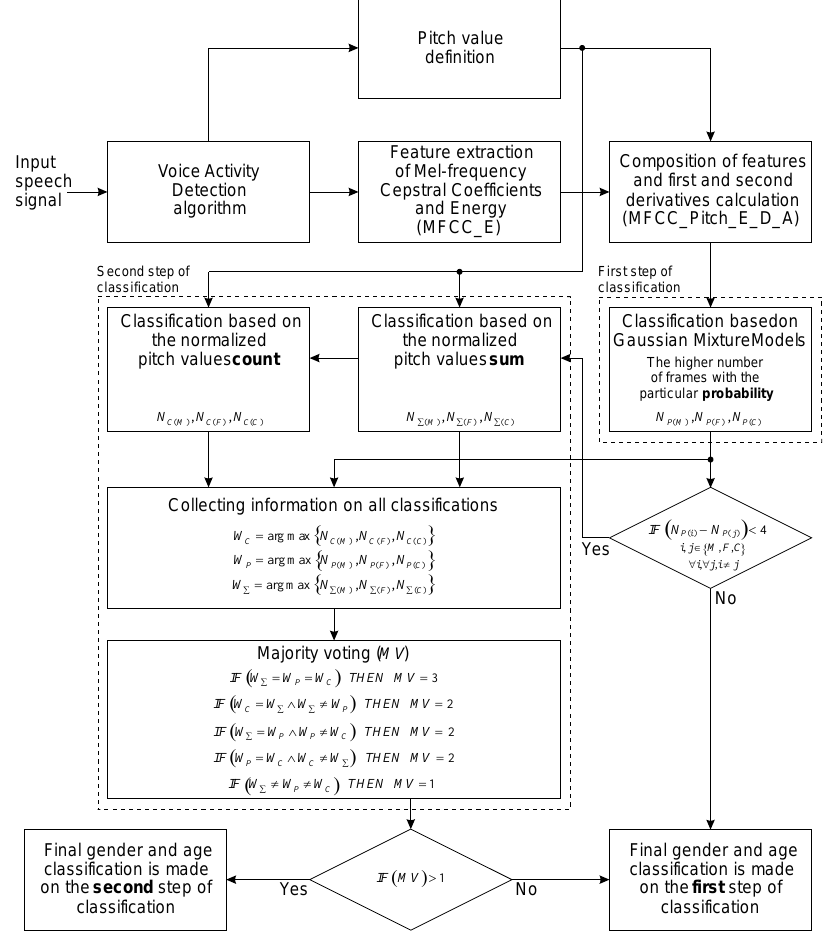
Figure 1. The proposed gender and age classification procedure.